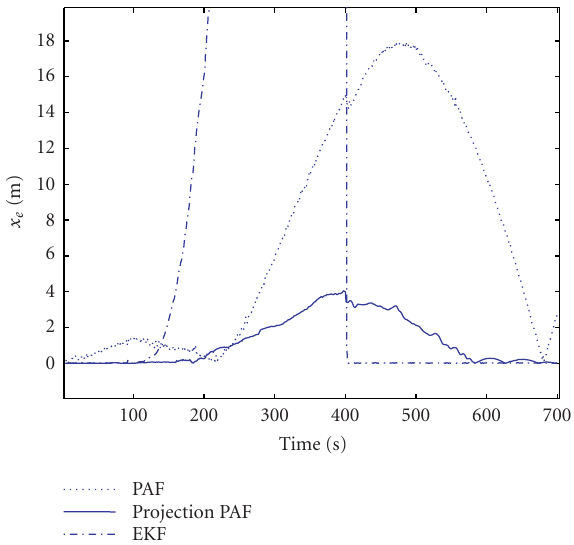
Figure 3: Details of Figure 2, where the di ff erence between the pro- jection PAF method and the PAF method is clear.